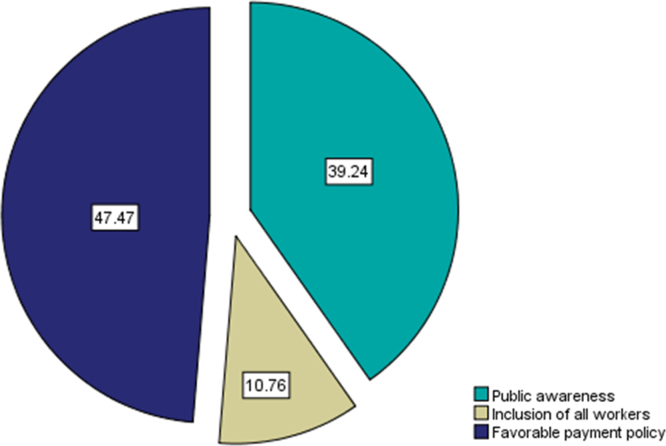
Public opinion on improvement strategies for social health insurance administration.